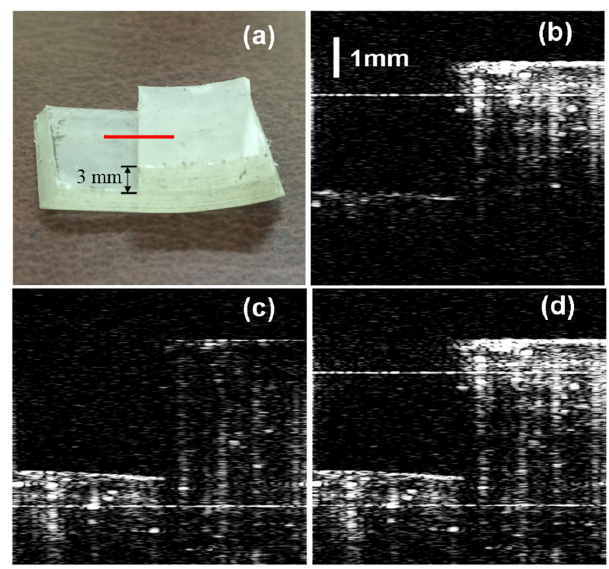
Figure 6. ( a ) The photograph of the artificial phantom of a step comprised of two blocks of sellotape. The red line is the lateral scan position on the phantom; ( b , c ) the cross-sectional optical coherence tomography (OCT) image of the phantom acquired with the conventional single-reference-arm approach; ( d ) the extended range OCT image acquired with the proposed two-reference-arm spatial frequency domain multiplexing approach. The blurry horizontal white line is the residual direct current (DC) term.